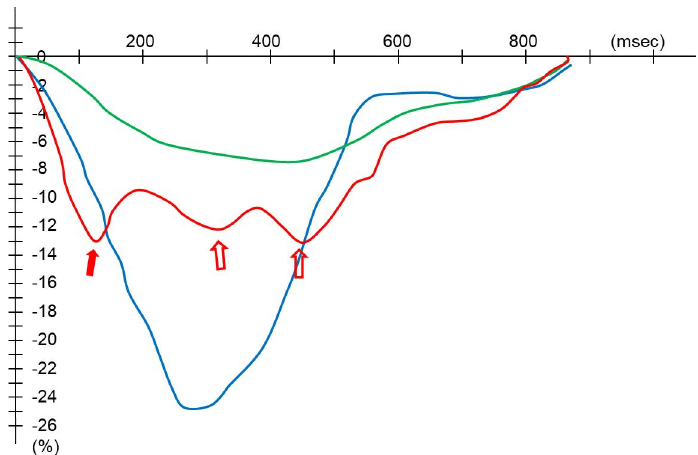
Fig 2. Strain curves for the regional wall motion abnormalities. Representative longitudinal strain curves are shown with the blue curve representing a normal contraction, the red a premature contraction, and the green hypokinesia or akinesia. Regional premature contraction was defined with the early systolic peak during the systole with decreased time to peak (red solid arrow) and overall decreased absolute values of global strains compared to the normal curve. An additional systolic peak (second or third) (red open arrows) could also indicate premature contraction. Regional hypokinesia or akinesia was defined with decreased absolute values of global strains and mild increased time to